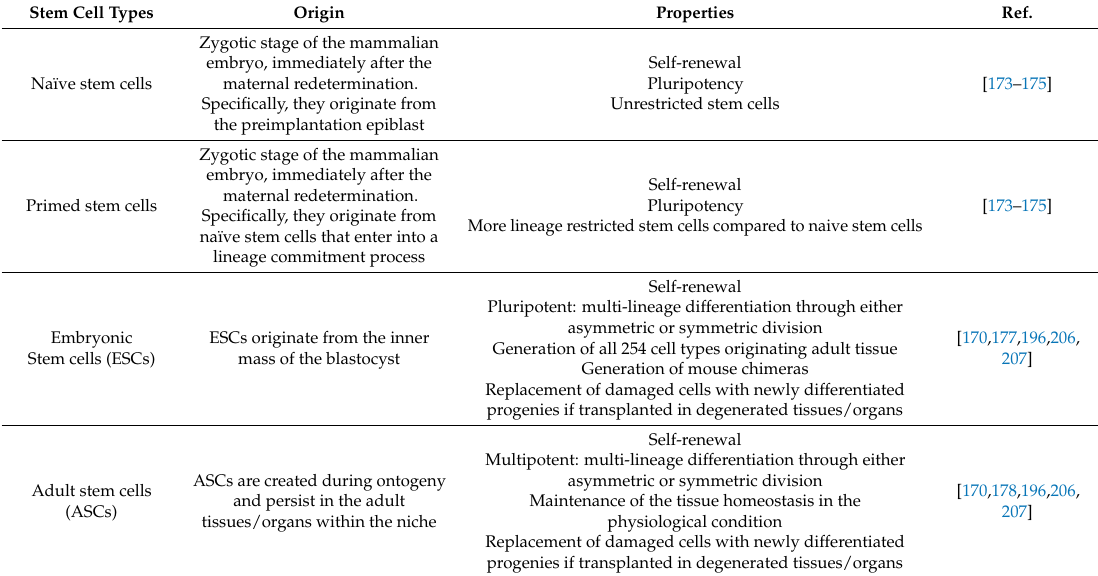
Table 3. Source of the origin the diverse types of stem cells and recapitulates the main characteristics of naïve, primed, ESCs, ASCs, iPSCs, and